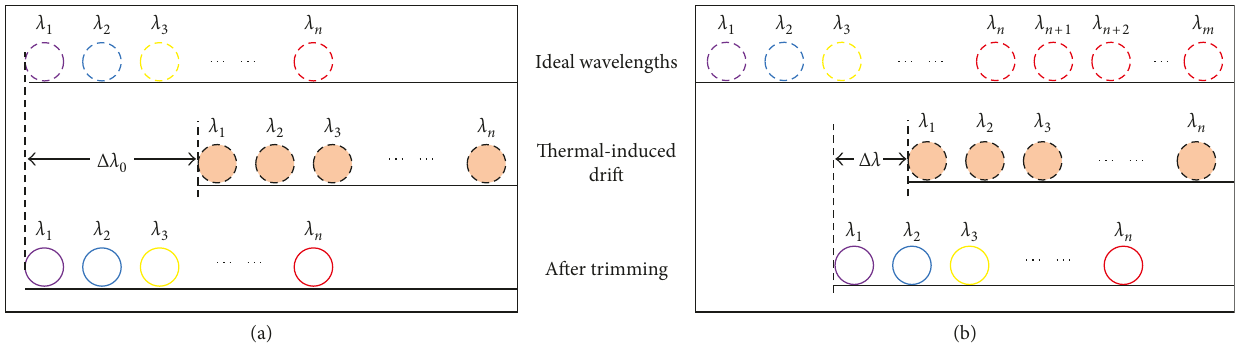
Figure 3: The trimming distance (a) without extra channels and (b) with extra channels.